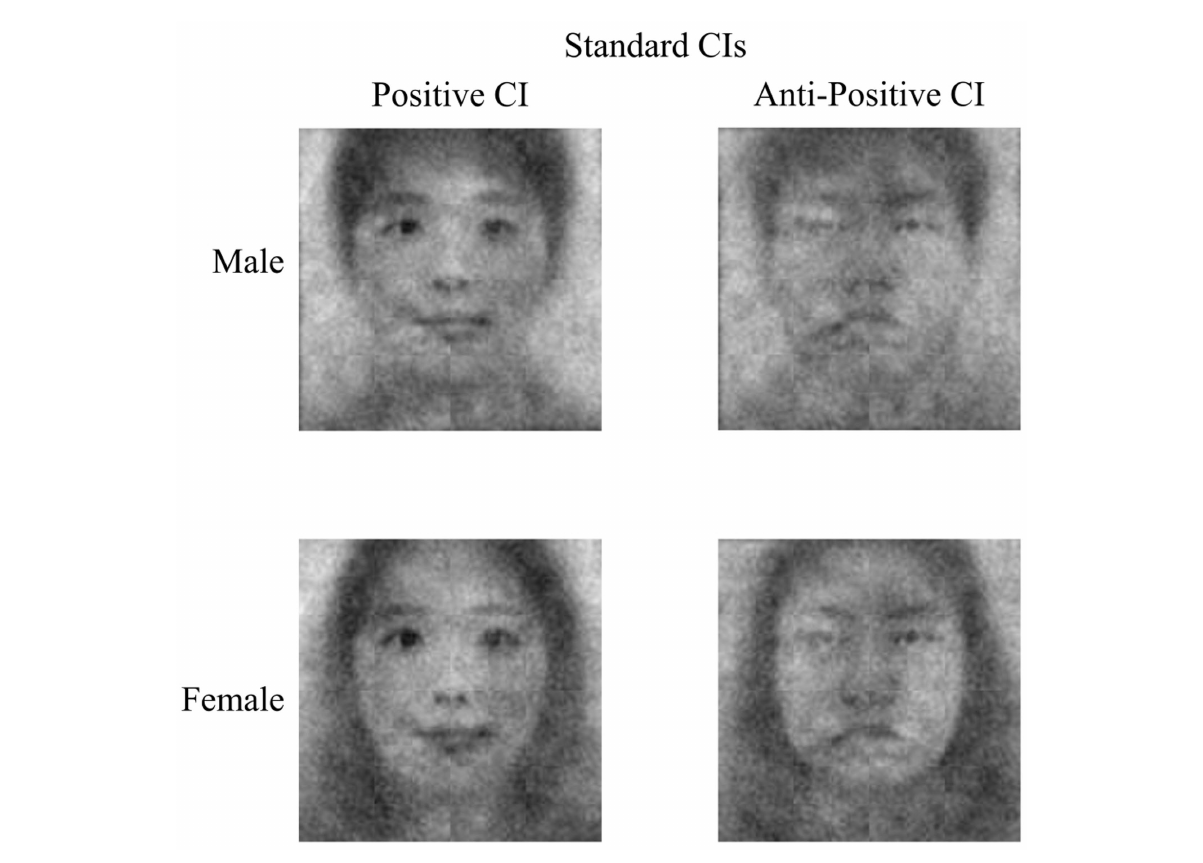
FIGURE 2 The standard classification images (CIs) generated by superimposing the averaged grayscale noise patterns of all selected images on the base images (left) and all non-selected images on the base images